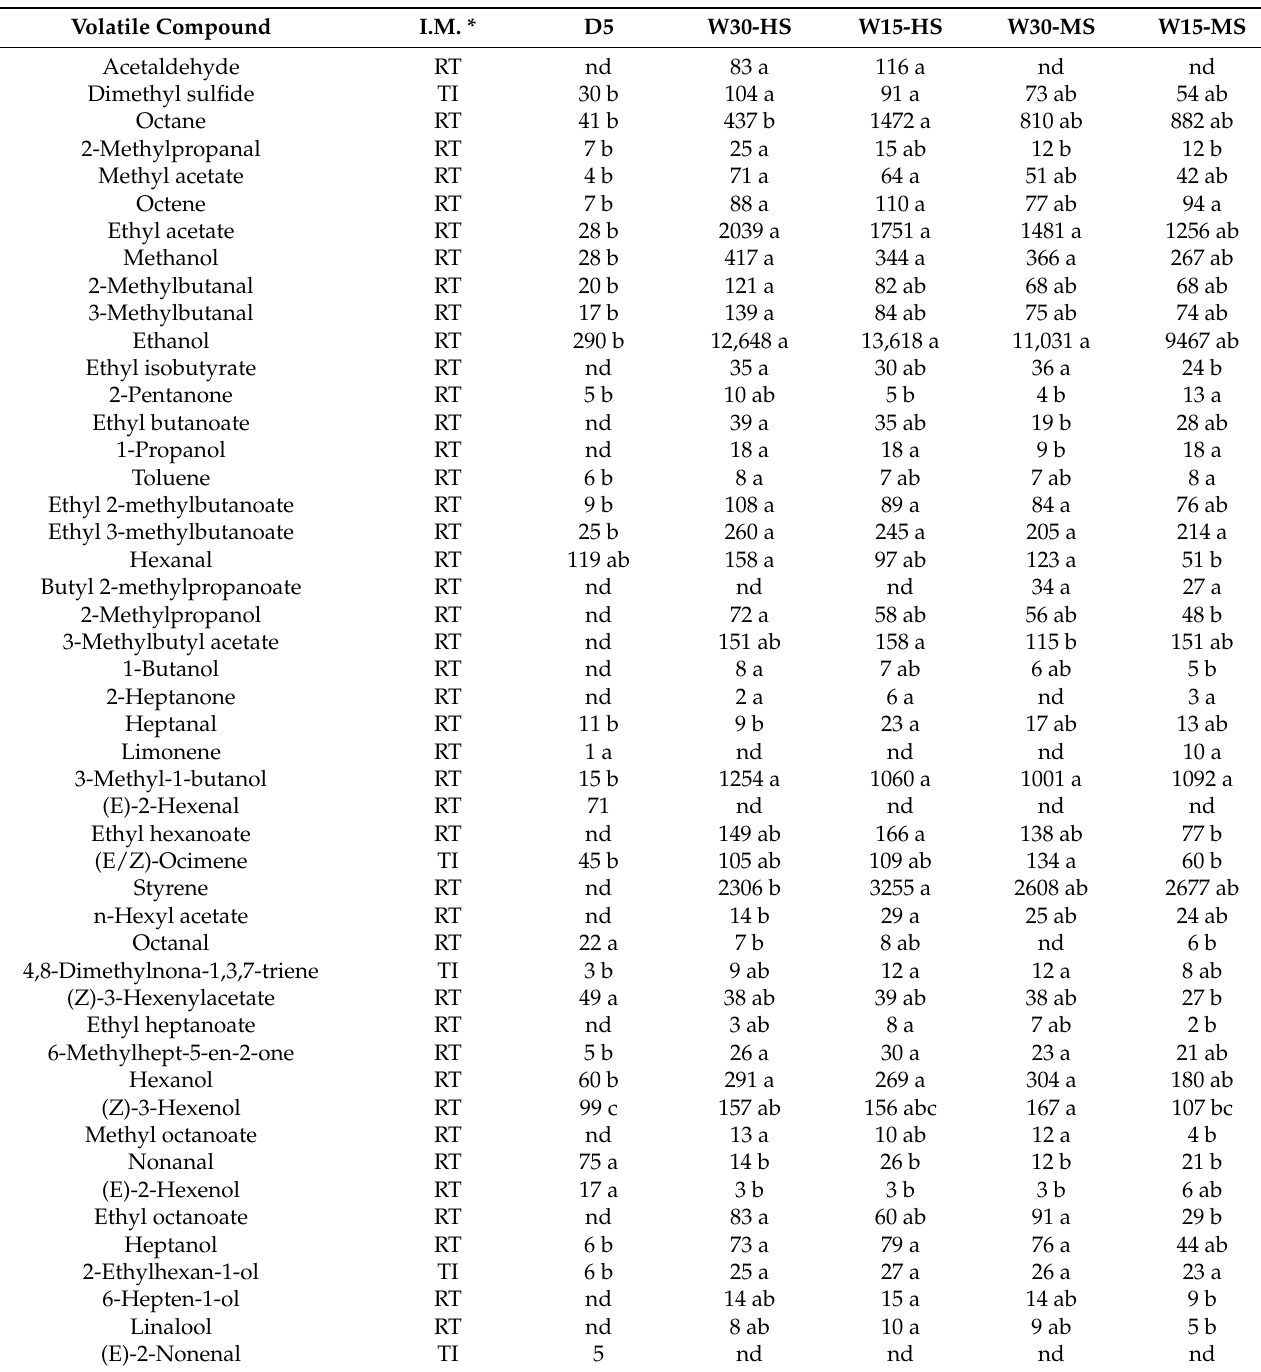
Table 3. Volatile compounds in ‘Itrana’ table olives processed by using different salt concentrations and fermentation times. Data were taken after 165 days from the beginning of the process, except for D5 (olives five days following the beginning of the treatment). Samples are as follows: 30 days in water and then salting with 8% NaCl brine (W30-HS); 15 days in water and then salting with 8% NaCl brine (W15-HS); 30 days in water and then salting with 6% NaCl brine (W30-MS); 15 days in water and then salting with 6% NaCl brine (W15-MS). Within each row, different letters indicate significant differences between treatments according to Tukey’s test ( p ≤ 0.05). Values are expressed as µ g internal standard per kg of olive pulp ( n =